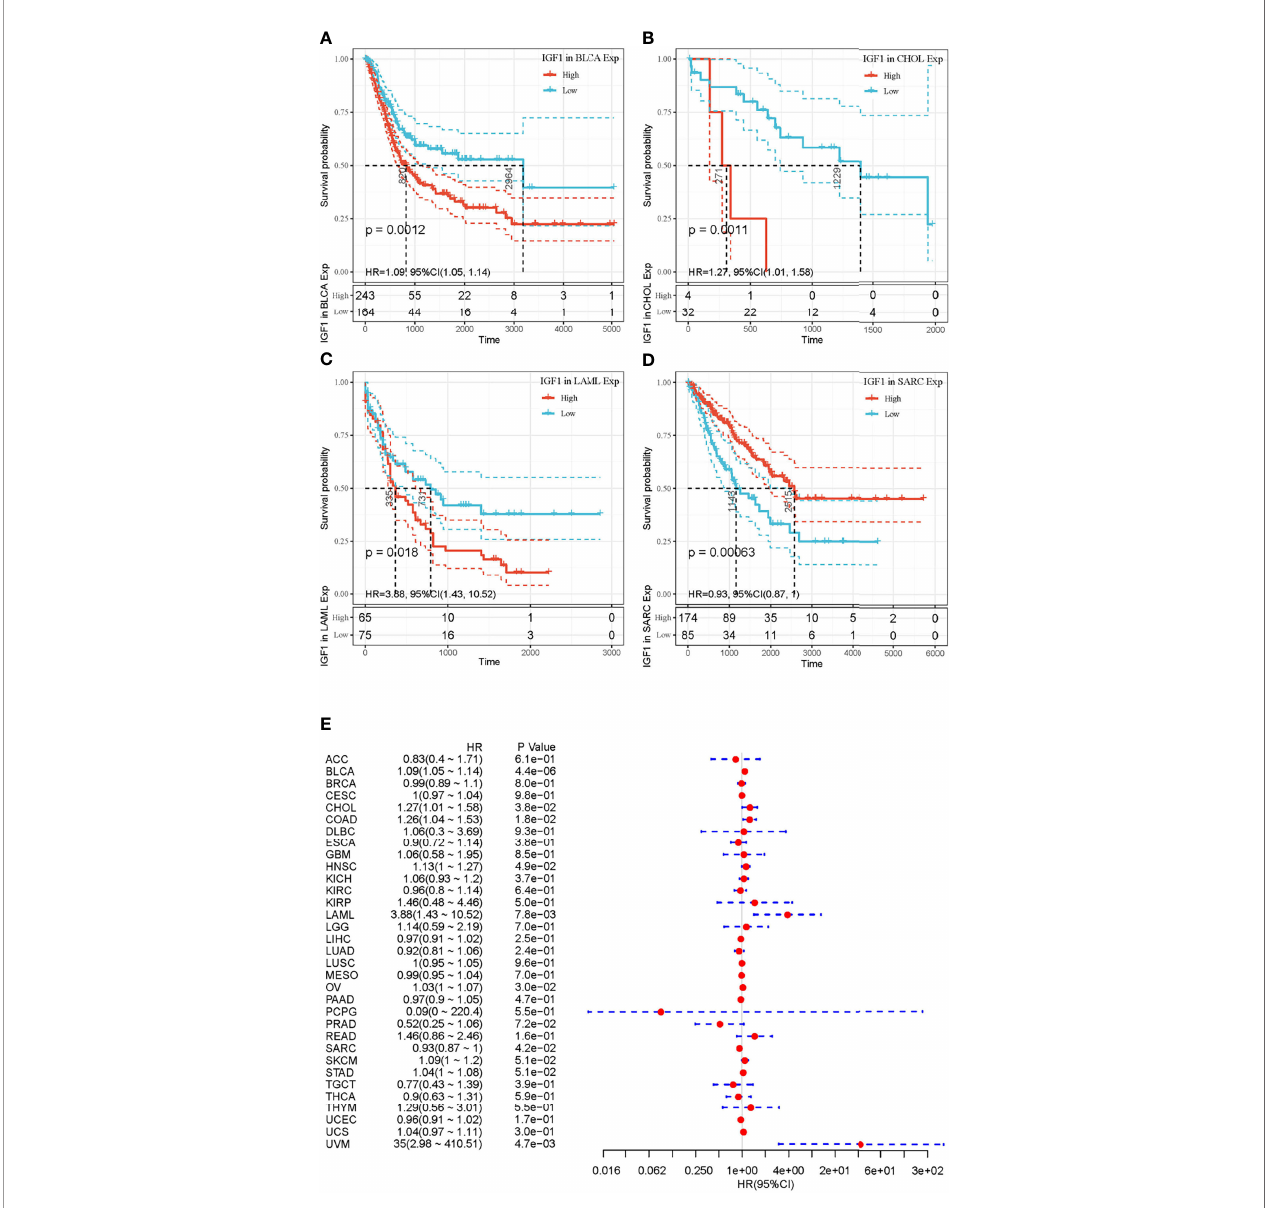
FIGURE 2 | Selected Kaplan-Meier plots and forest plot comparing the high and low expressions of IGF-1 on overall survival across different cancers. (A – C) Kaplan-Meier method showed high expression of IGF-1 correlated with unfavorable prognosis in BLCA, CHOL, and LAML. (D) Kaplan-Meier method showed high expression of IGF-1 correlated with favorable prognosis in SARC. (E) Forest plot displaying the impact of high expression of IGF-1 on OS across 33 cancer types using Cox regression model. Con fi dence level is shown in dashed